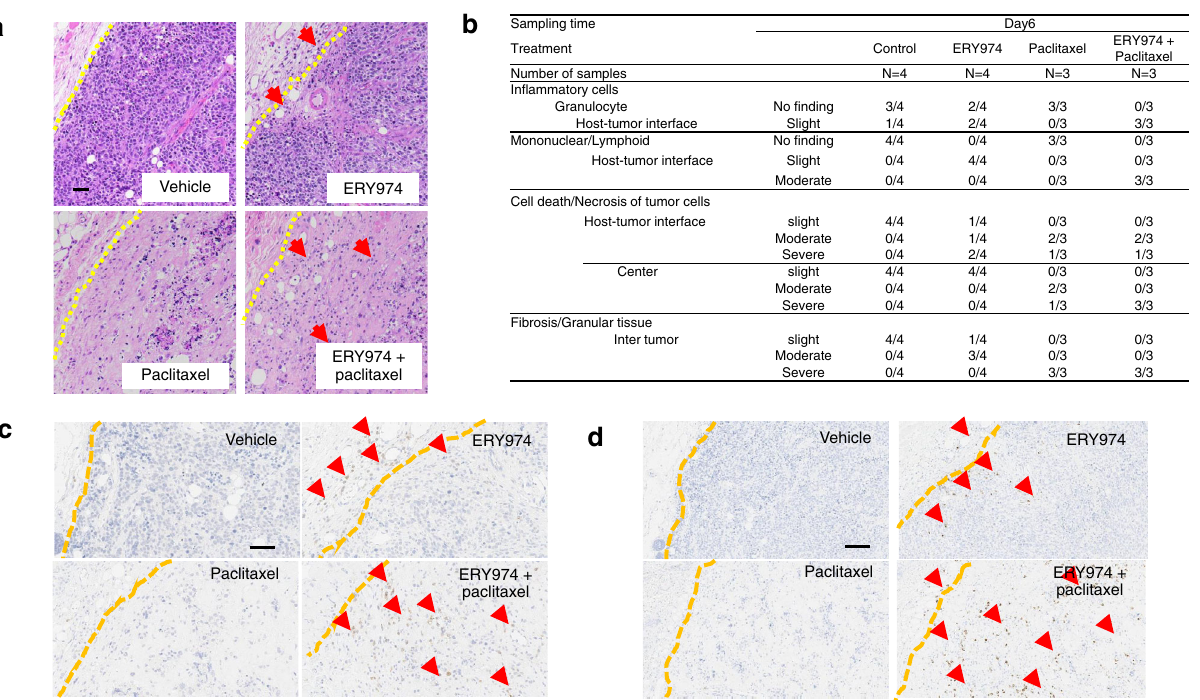
Fig. 4 | ERY974 combined with paclitaxel increases in fi ltration of T cells and macrophages into the centre of the non-in fl amed NCI-H446 tumour. Tumour tissueswerepreparedfromNCI-H446xenografttumoursofhuNOG mice( n =3for paclitaxel and ERY974+paclitaxel groups; n =4 for vehicle and ERY974 groups). a HE staining. Yellow dotted line indicates tumour-stromal boundary; arrows